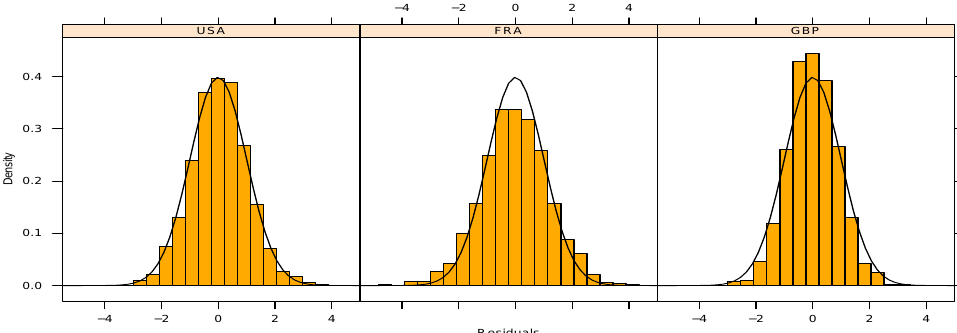
Figure A3. Histograms of residuals: Comparison of the historical residuals’ densities (histograms) and a standard Gaussian density (lines).